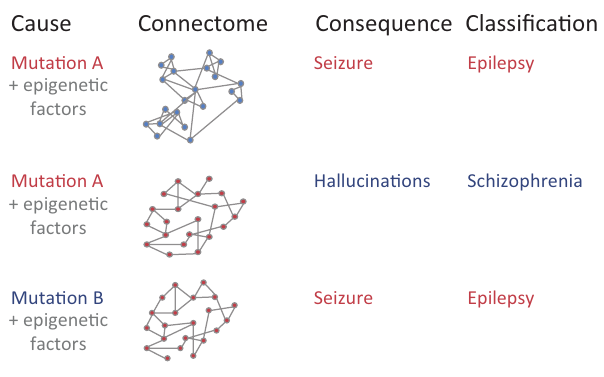
FIGURE 1 | Mapping between underlying developmental causes of connectome changes, ranging from genetic factors to spatiotemporal epigenetic factors, to resulting brain connectivity (“connectome”), observable network behavior (“consequence”), and final disease classification . Similar patterns within each of the four categories are shown in red. Note that both genetic patterns and network features alone may be insufficient to inform the clinical diagnosis of a disease: first, the same genetic mutation A might lead to a different connectivity due to different epigenetic factors. Second, different genetic mutations A and B could lead to the same connectivity due to additional factors. Third, the same connectivity might lead to different behavior and disease classification due to changes that solely affect the anatomical organization within individual